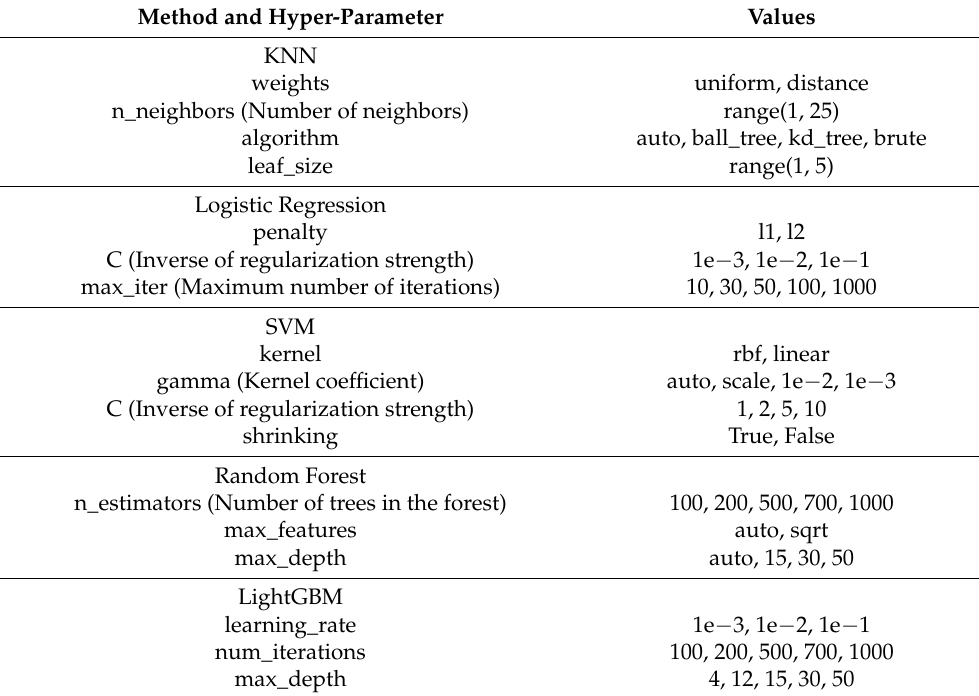
Table 3. Hyper-parameter range for